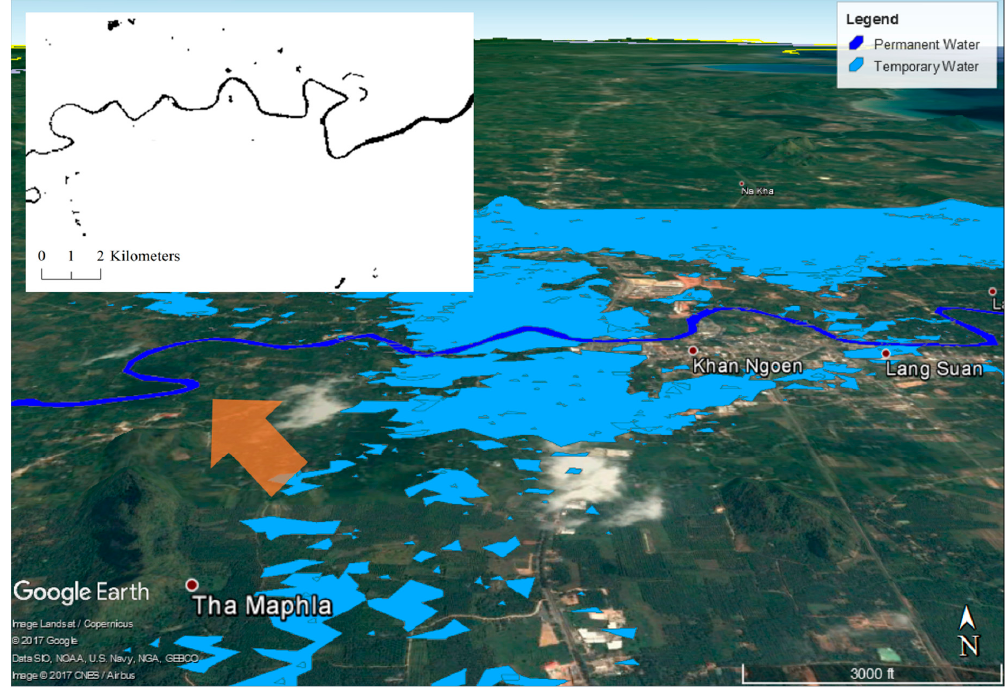
Figure 10. Discrimination between the Lang Suan River in dark blue and the flooded areas in light blue in the Lang Suan district, Chumphon.